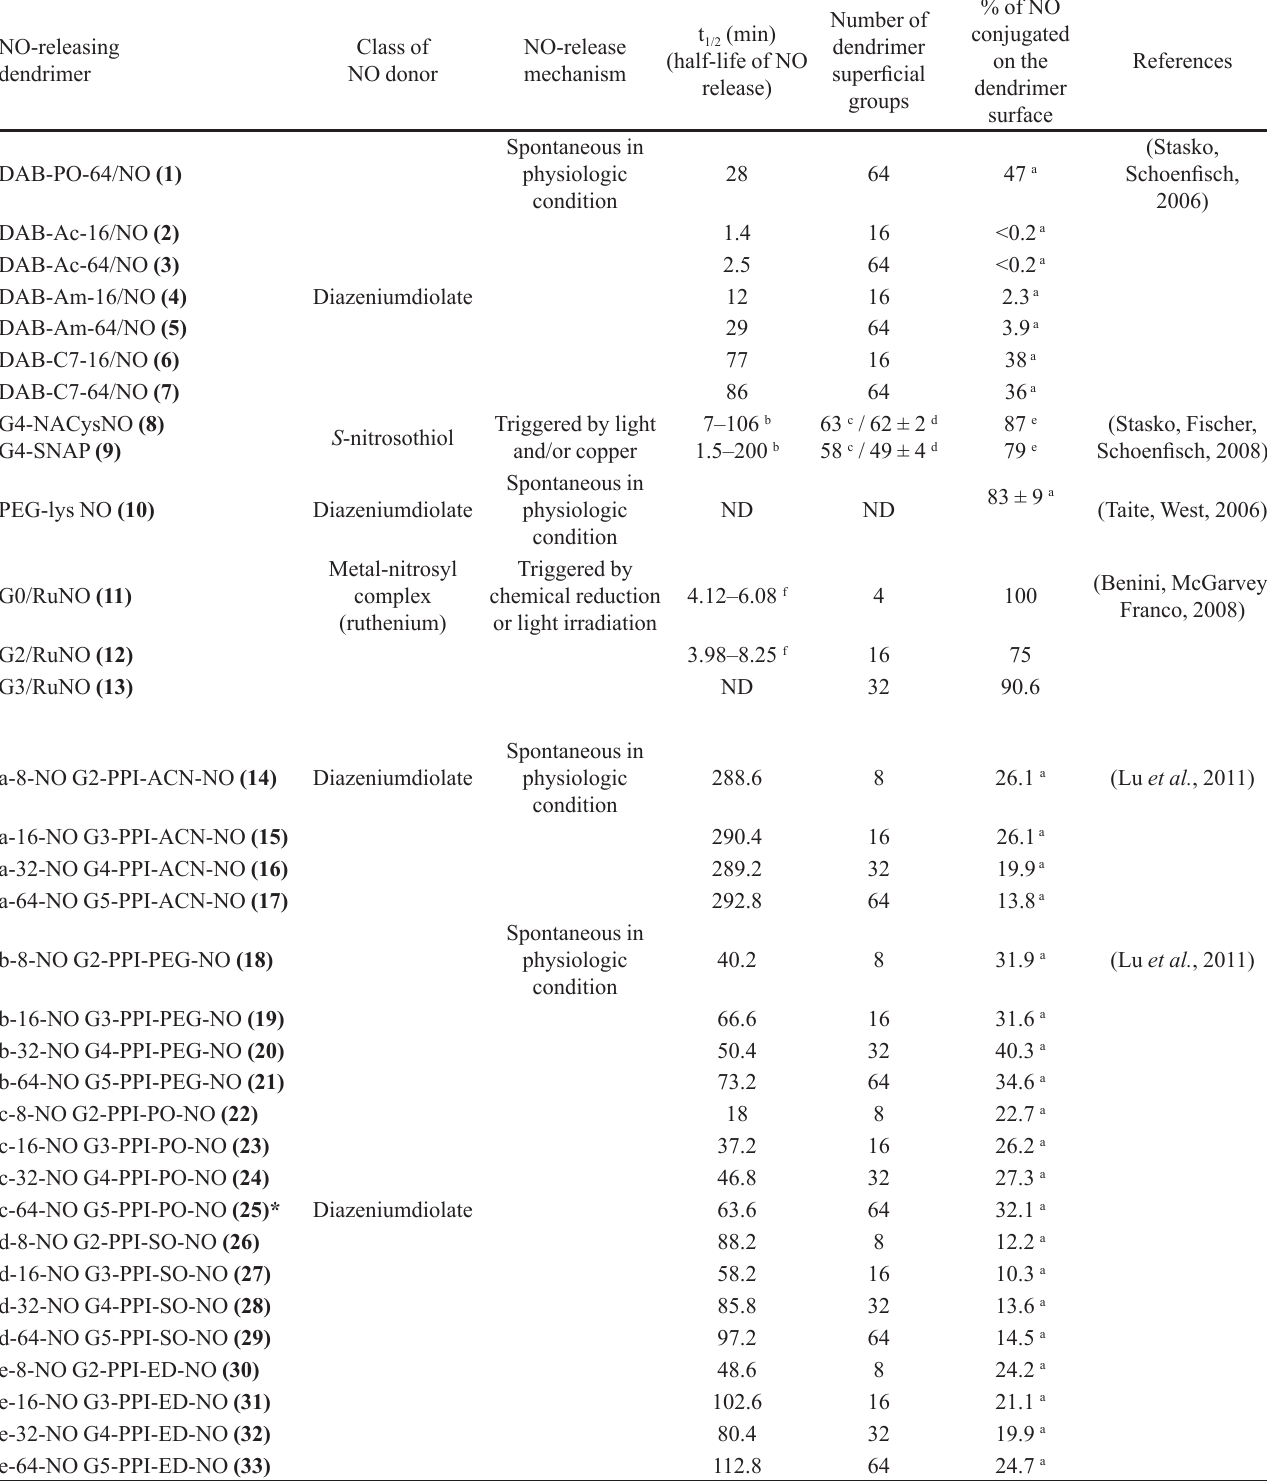
TABLE I - General properties of NO-releasing